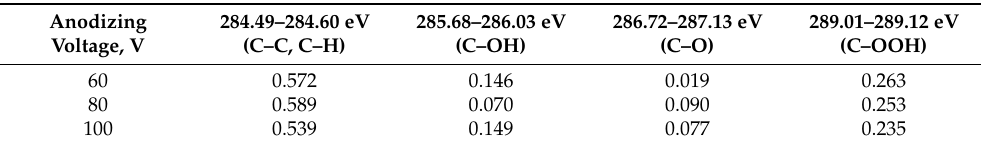
Figure 5. Deconvoluted C 1 s XPS spectra of carbonaceous species entrapped inside the films fabricated by Al anodization at E a values of 60 ( a ), 80 ( b ), and 100 ( c ) V for 60 min. Table 3. The relative proportions of carbon species according to C 1 s spectrograms of the films fabricated as in Table